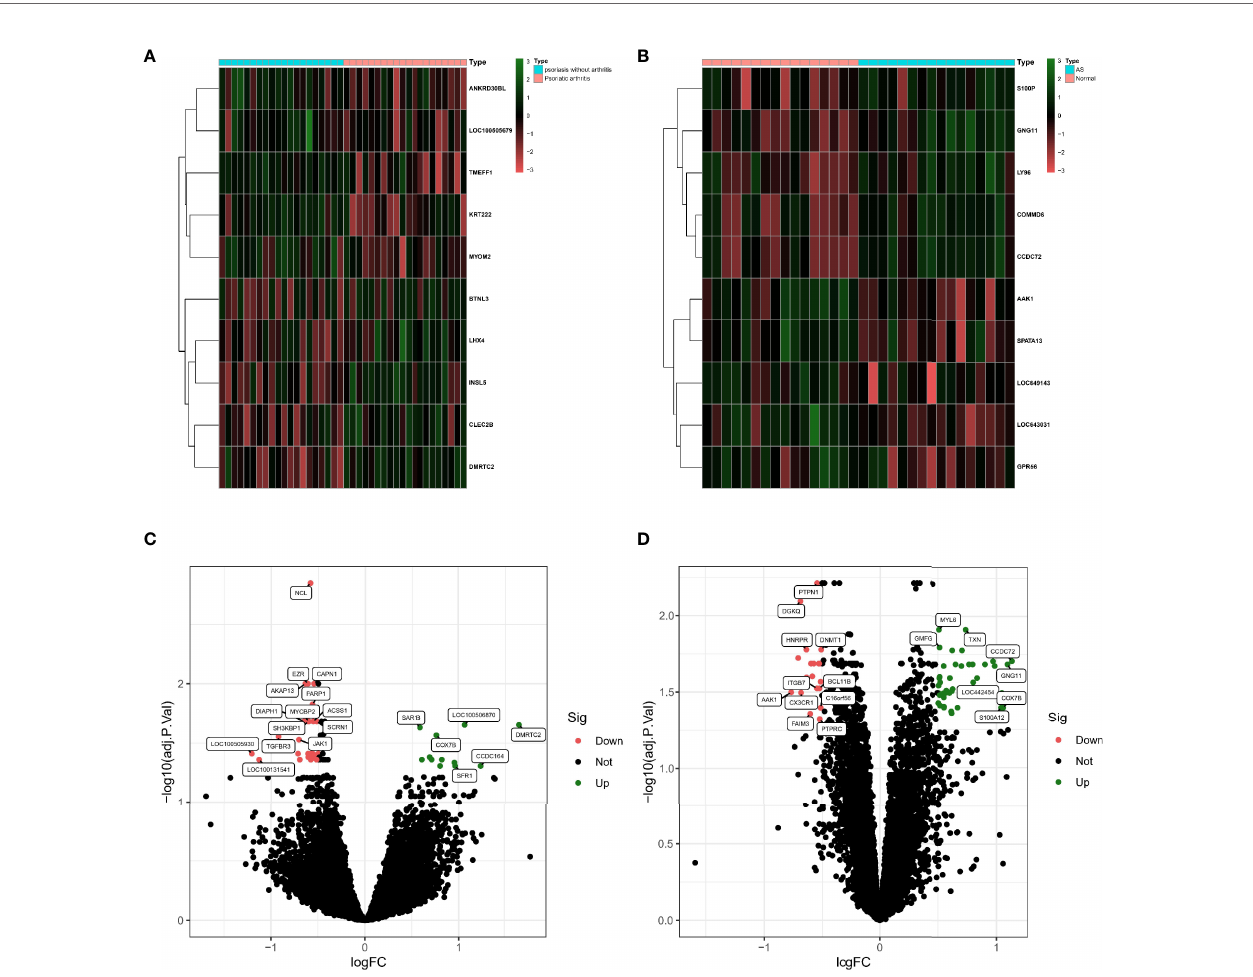
FIGURE 1 | (A) Heatmap of DEGs in GSE61281 (n = 37, adj. p < 0.05, |log2 fold change FC| < 0.5). (B) Heatmap of DEGs in GSE25101 (n = 62, adj. p < 0.05, |log2 fold change FC| > 0.5). (C) Volcano plot of DEGs in GSE61281. (D) Volcano plot of DEGs in